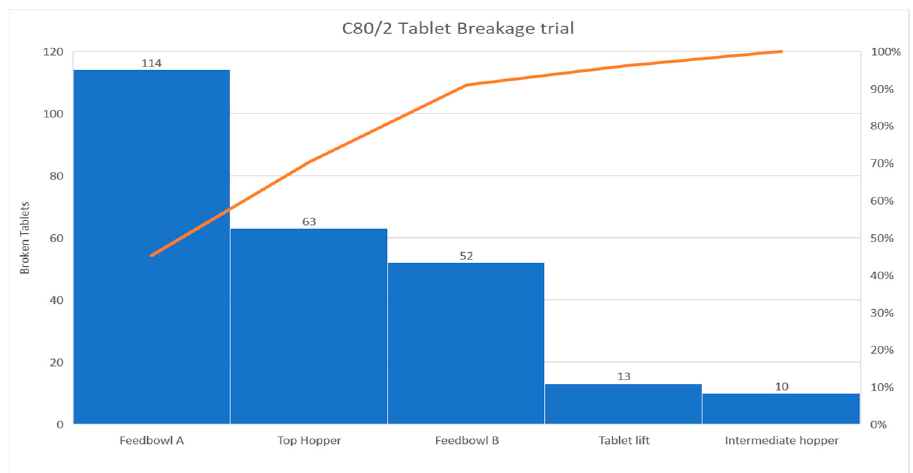
Figure 13. Pareto graph demonstrating the results of a trial to establish when tablets break within the Packaging process. It was demonstrated that 70% of breakages of tablet type C80/2 were in the Feed Bowl and Top hopper areas.